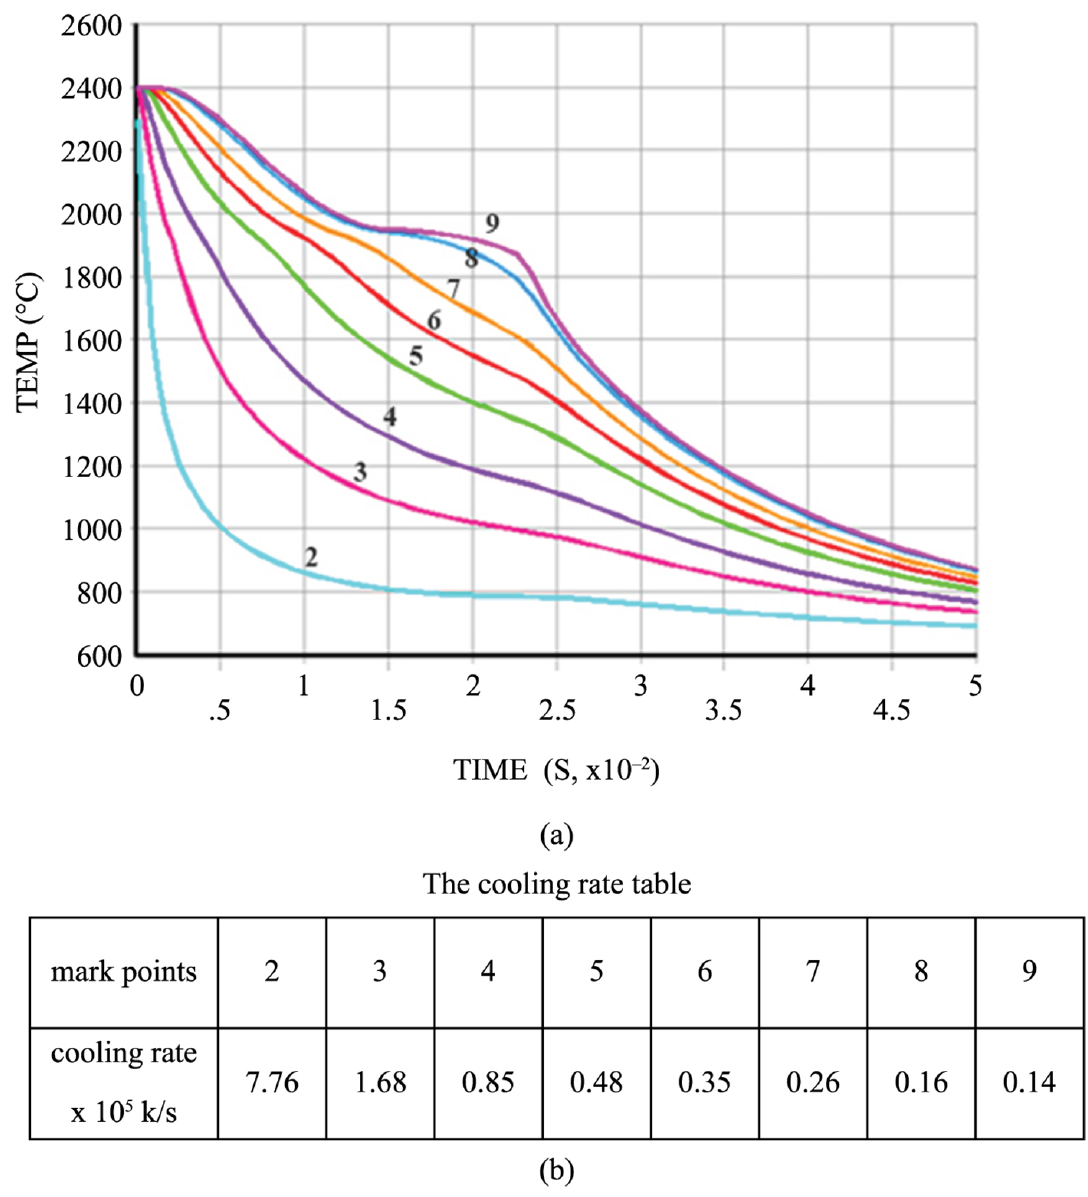
Figure 4. The temperature over time (a) and the cooling rate at solidification temperature (b) of mark points during Al solidification.